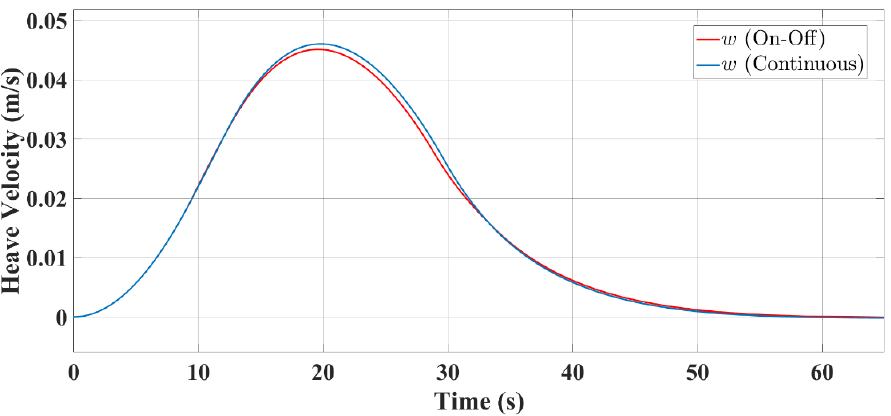
Figure 8. Heave velocity responses of on-off and continuous type VBS control.